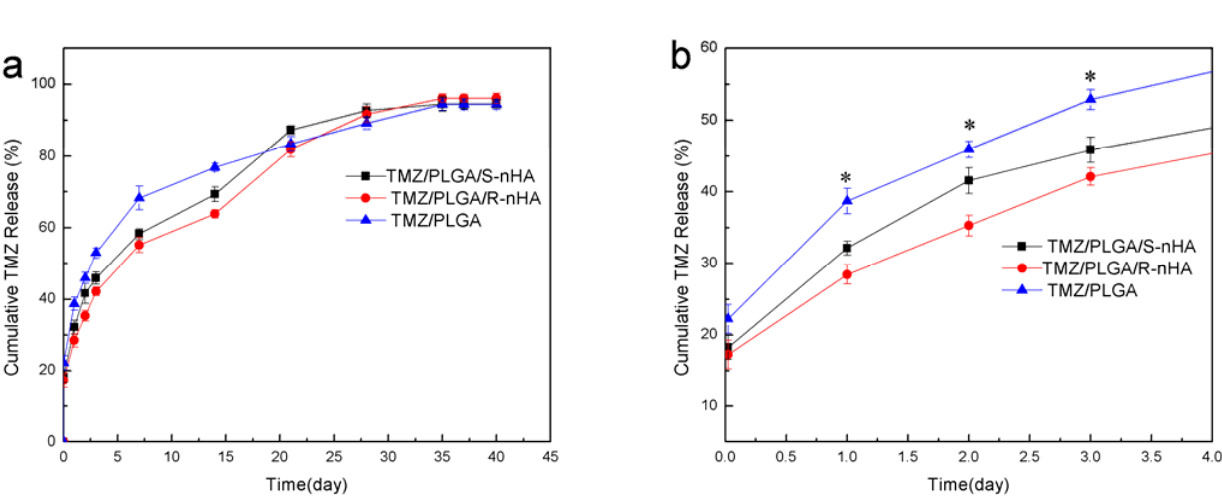
Figure 4. The profiles of TMZ released from TMZ/PLGA, TMZ/PLGA/S-nHA and TMZ/PLGA/R-nHA. ( a ) Within 40 days; ( b ) Within 3 days. * p < 0.05: significant against the TMZ/PLGA group.